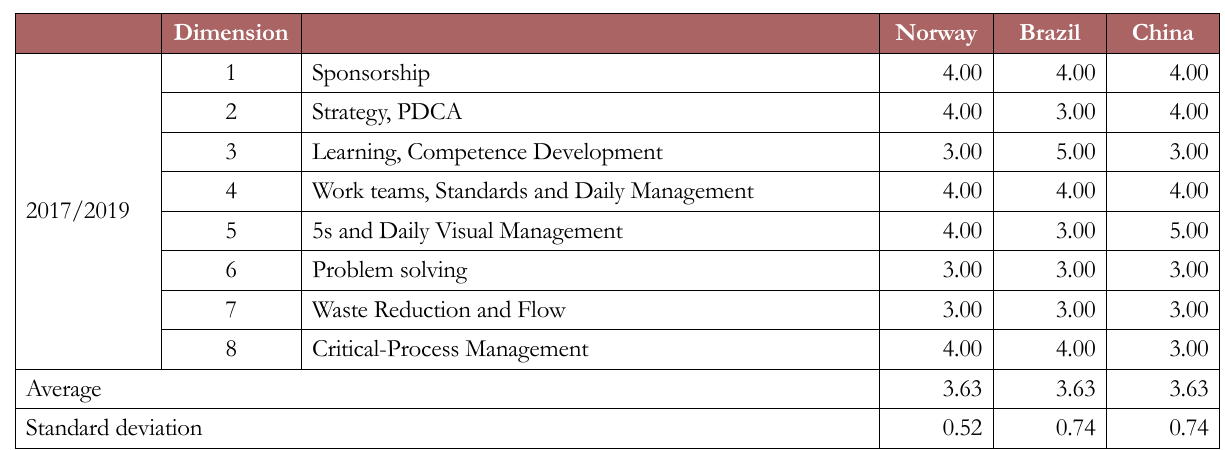
Table 4. Assessment data for XPS